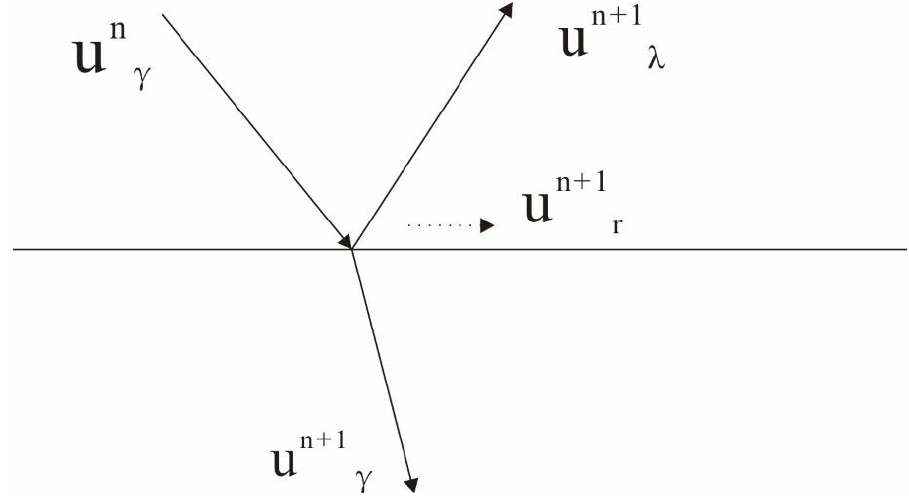
Figure A1. Wave field after wave decomposition. The zeroing matrix is expressed as: